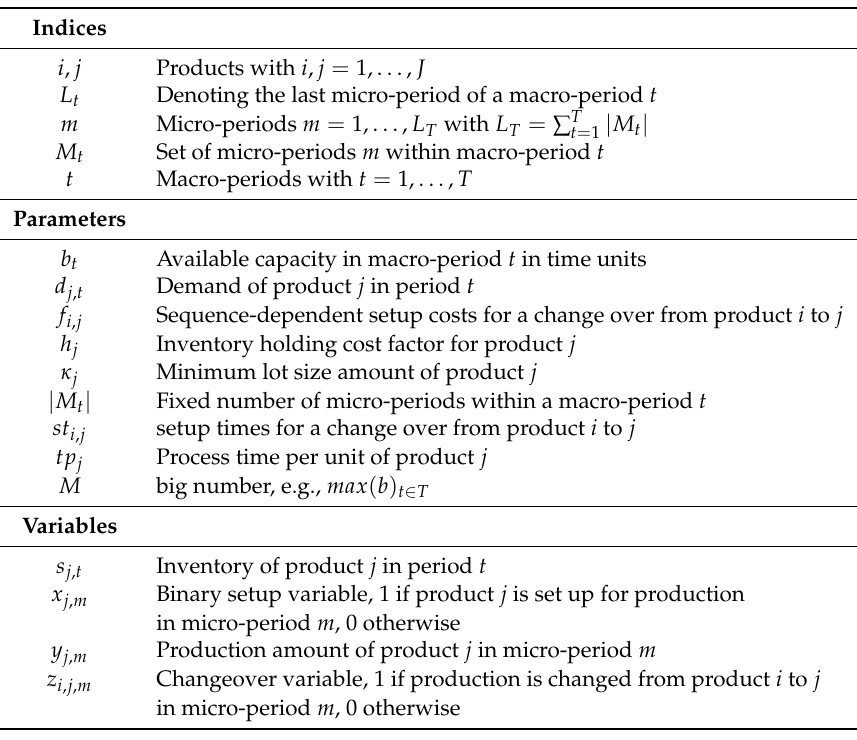
Table 1. Variables, parameters and indices used in the